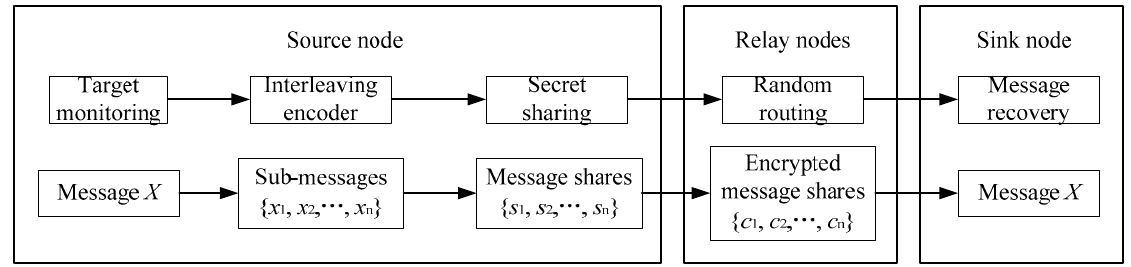
Figure 3. Process of data sharing between the source node and sink node.